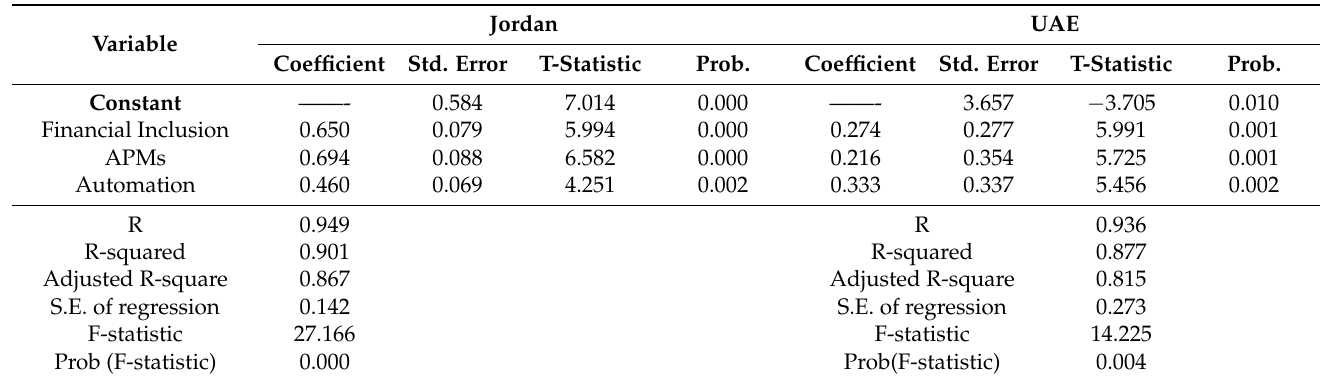
Table 9. Results of the Multiple Regression Test for the First